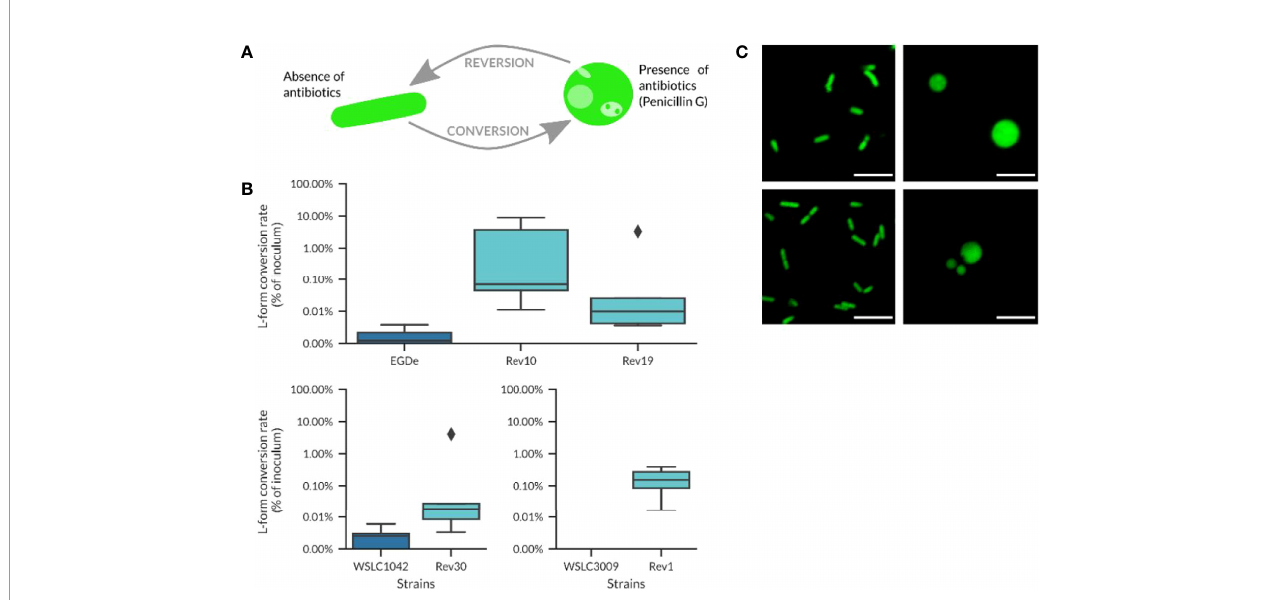
FIGURE 2 | Revertant strains used in this work. (A) Schematic overview about the conversion/reversion cycle of Listeria revertant strains. Penicillin G was used to trigger the conversion of parental Listeria cells to the L-form state. By plating on DM3 agar without drug selection, L-forms revert back to the walled state. (B) Conversion rates for different revertant strains compared to their wild-type origin. Revertant strains tend to have a higher conversion rate, although the percentage of converting bacteria is in most cases below 1% and the conversion values are not signi fi cantly different between wild-type strains and their respective revertant strains (Welch ’ s t-test, p-value > 0.05). (C) Micrographs of revertant cells at the walled (left) and L-form state (right) following Penicillin G treatment (100 µg/ml). Top row: L. monocytogenes strain Rev10 (serovar 1/2a); lower row, strain Rev30 (serovar 4b). Scale bar = 5